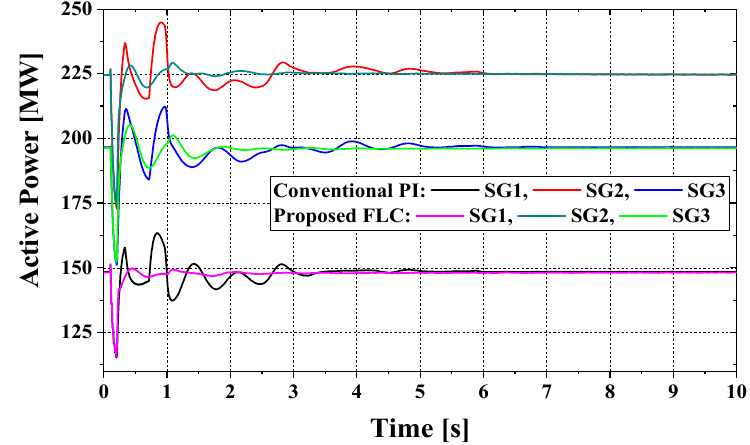
Figure 12. Rotor speed profile of the SGs.